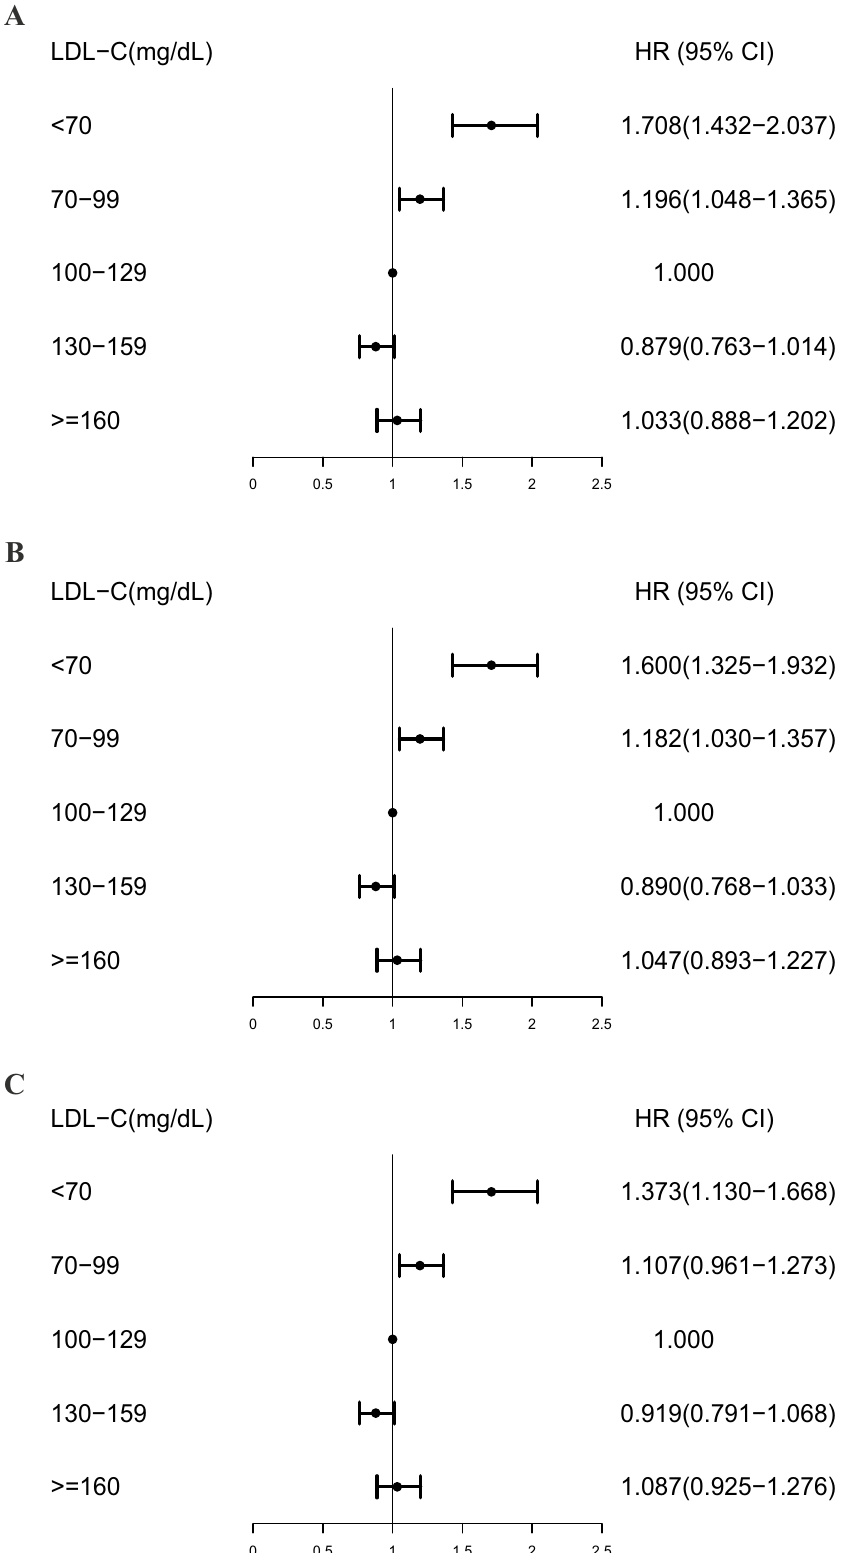
Figure 1. Multivariate analysis of low-density lipoprotein cholesterol (LDL-C) level and covariates associated with all- cause mortality in the NHANES Study, 1999–2014. ( A ) Age-adjusted model (model 1), adjusted for age (continuous). ( B ) Crude-adjusted model (model 2), adjusted for age (continuous), sex, race, marital status, education level, smoking status, BMI (continuous). ( C ) Fully-adjusted model (model 3), adjusted for age (continuous), sex, race, marital status, education level, smoking status, BMI (continuous), hypertension, diabetes, cardiovascular disease,